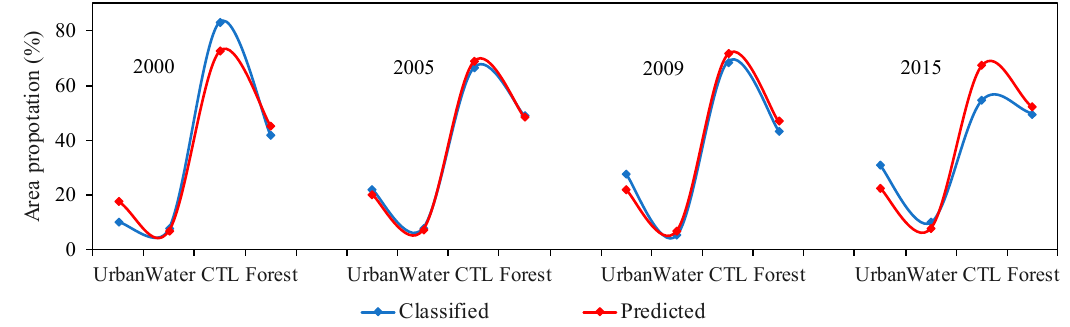
Figure 8. Classified and predicted land use area proportion from 2000 to 2015.